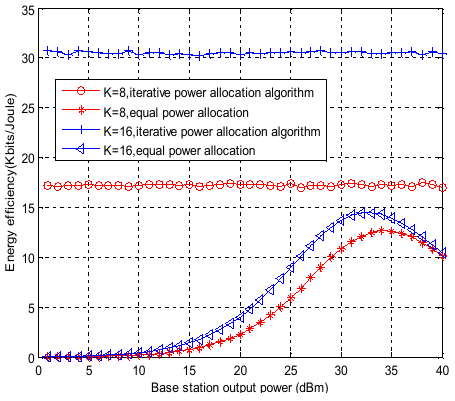
Figure 4 . Energy efficiency comparison between iterative power allocation algorithm and equal power allocation